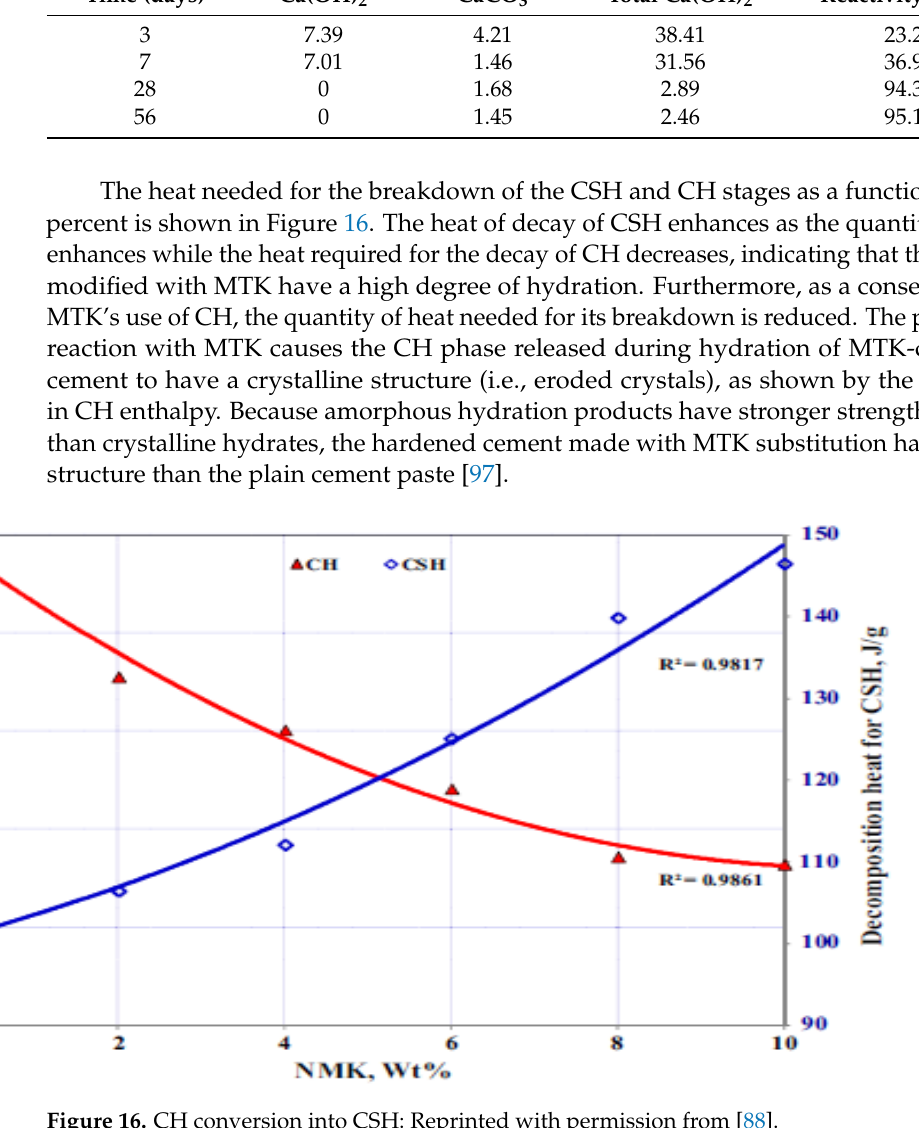
Figure 16. CH conversion into CSH: Reprinted with permission from